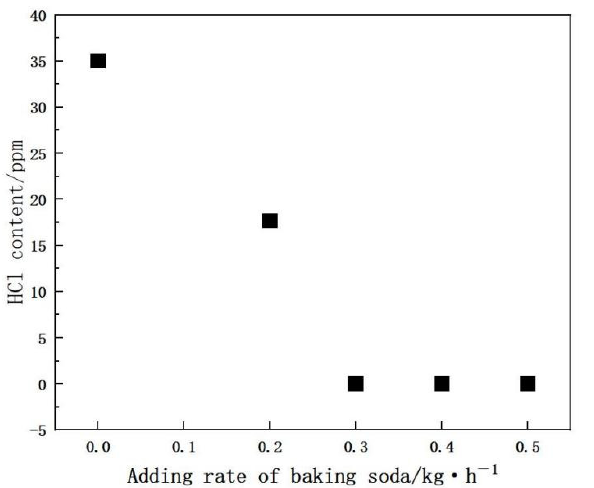
Figure 6. Effect of baking soda addition rate on HCl concentration in flue gas.